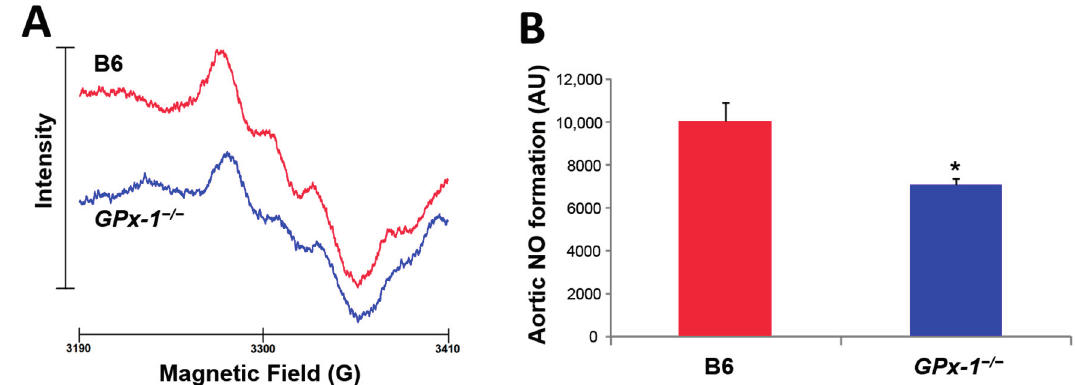
Figure 4. Nitric oxide formation in isolated aortic ring segments in old (12 mo) wild type (WT) and GPx-1 knockout mice. • NO was measured in aortic ring segments (1 thoracic aorta for each measurement) upon stimulation with calcium ionophore (A23187, 10 µM)